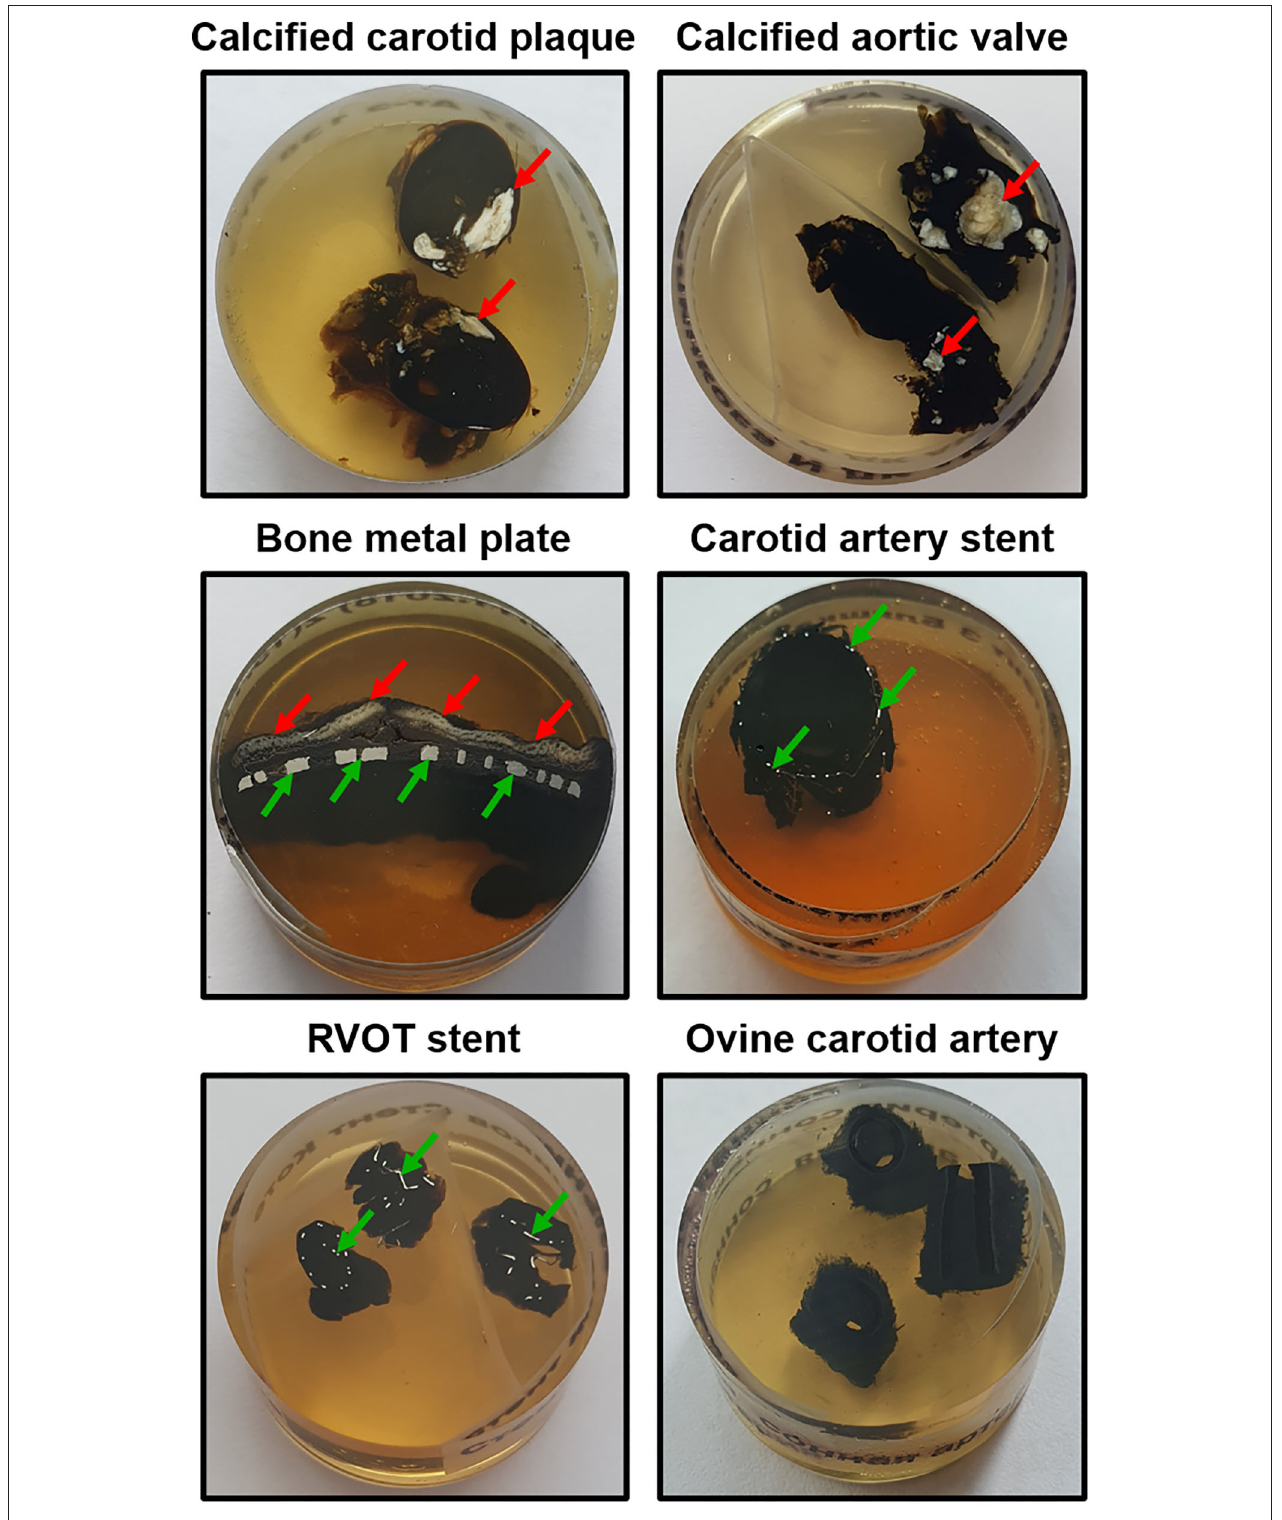
FIGURE 1 | Appearance of grinded and polished epoxy resin blocks containing various tissue samples (mineralised carotid plaque, calcified aortic valve, bone metal plate, stented carotid artery and right ventricular outflow tract, and intact non-calcified ovine carotid artery). Calcified and metal inclusions are indicated by red and green arrows, respectively. RVOT, right ventricular outflow